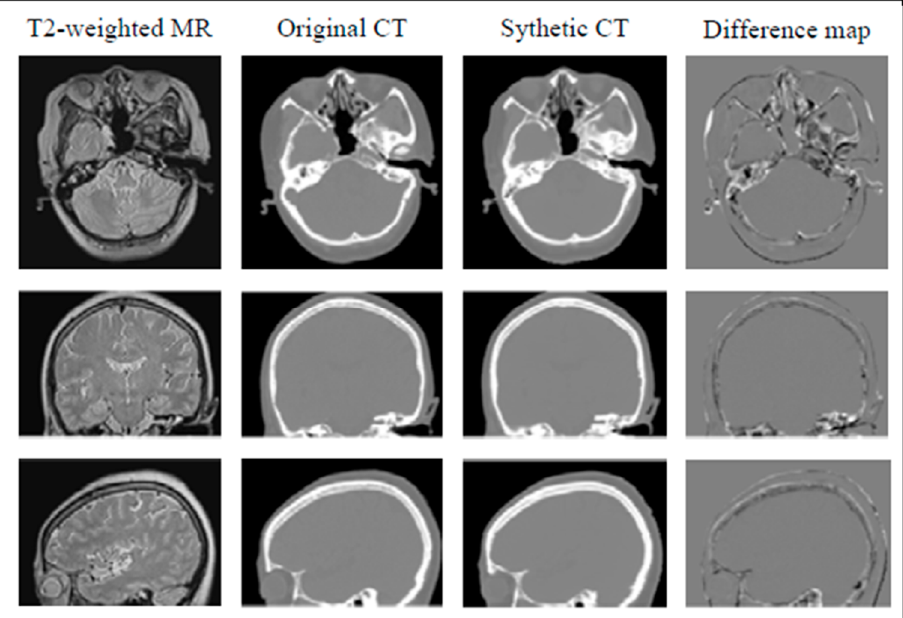
Figure 10. Example synthetic CT images from T2-weighted MRI in comparison to the original CT images. Reprinted with permission from [60].